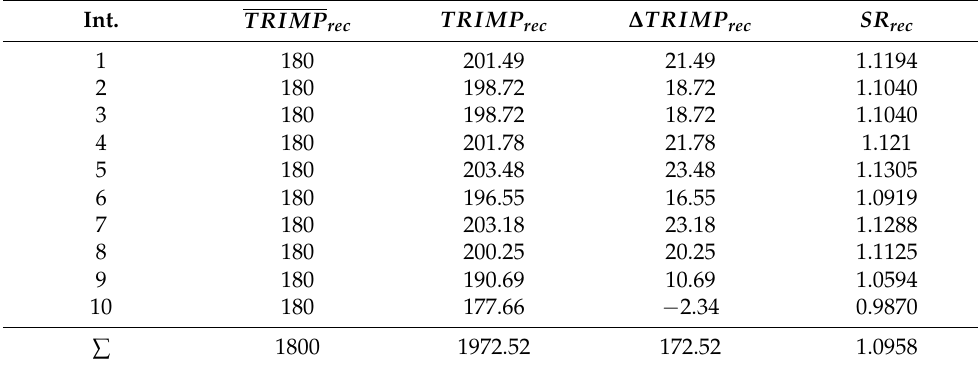
Table 4. Professional cyclist results by interval recovery